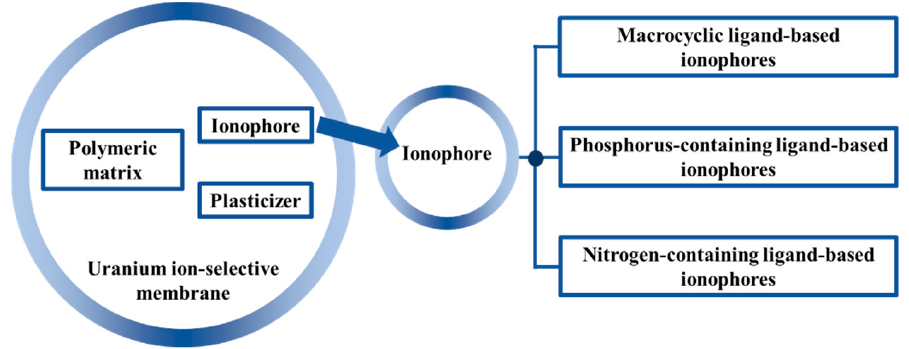
Figure 2. The components of the uranium ion-selective membranes and the classification of iono- phores in ion-selective membranes for the detection of uranium ions.